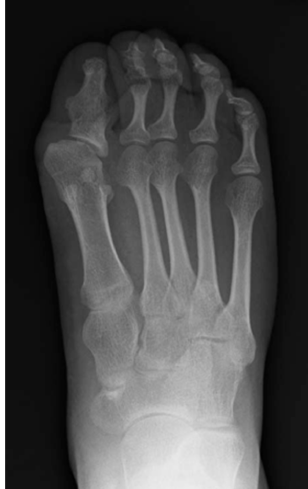
Figure 4. Anteroposterior radiograph of the right foot of 20-year-old female with FOP demonstrating medially deviated metatarsal bone and fused proximal and distal phalanges.